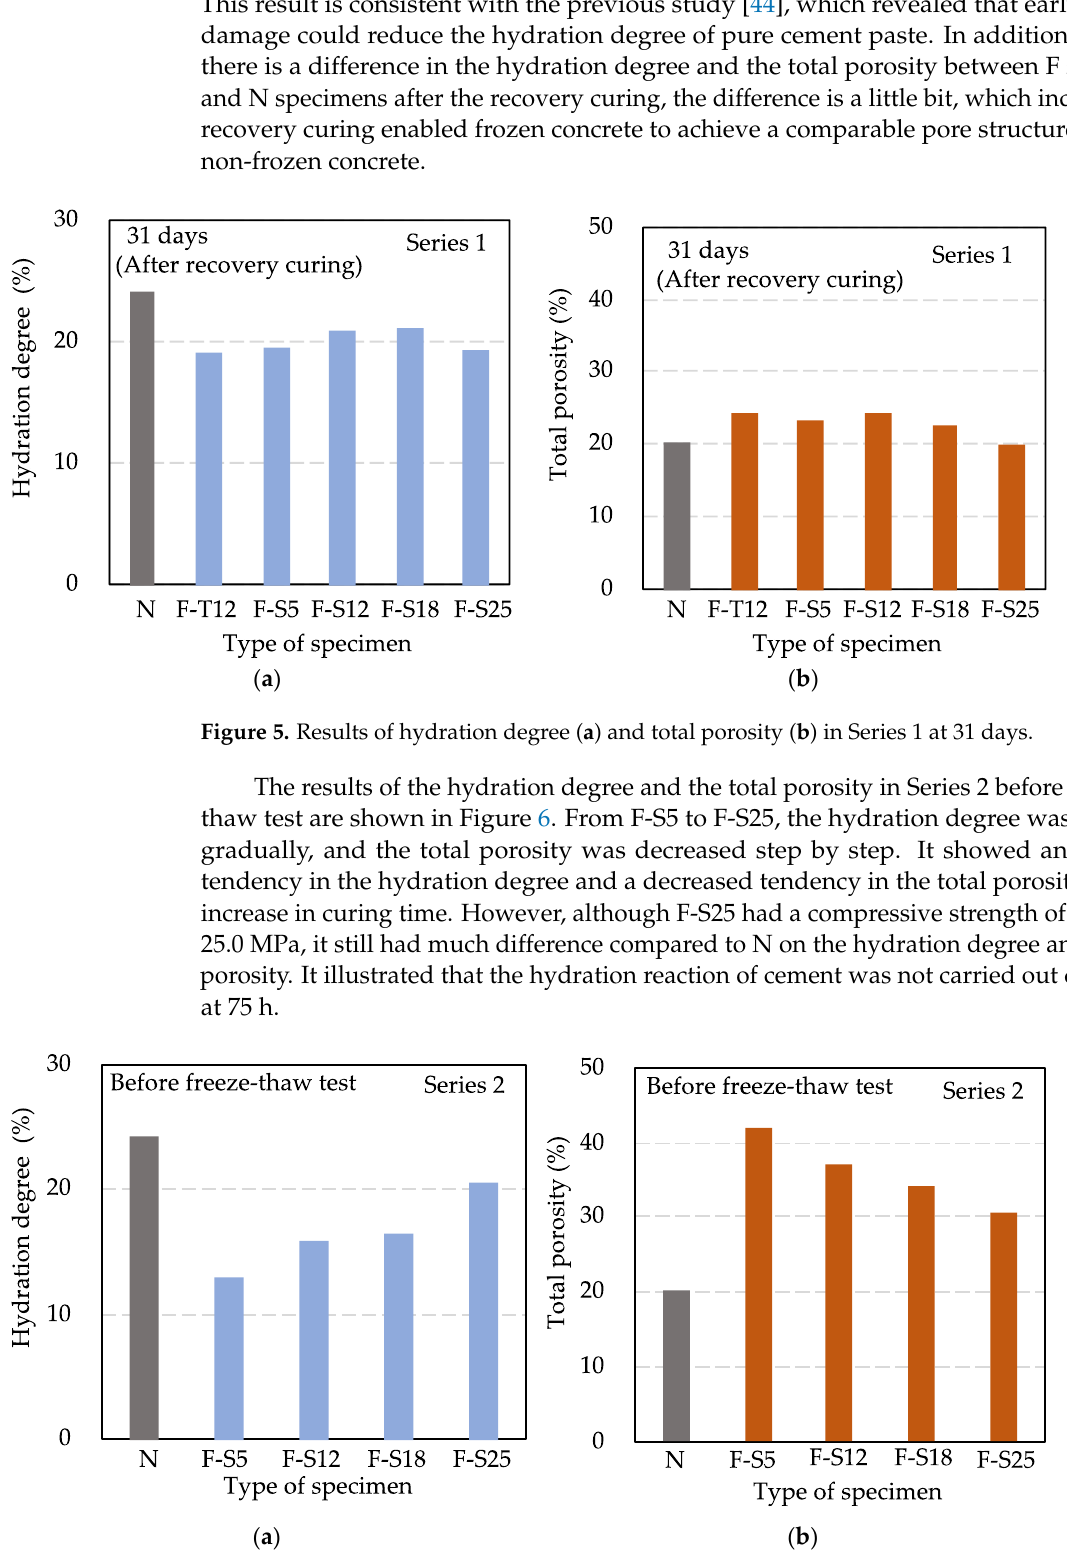
Figure 6. Results of hydration degree ( a ) and total porosity ( b ) in Series 2 before freeze – thaw test.